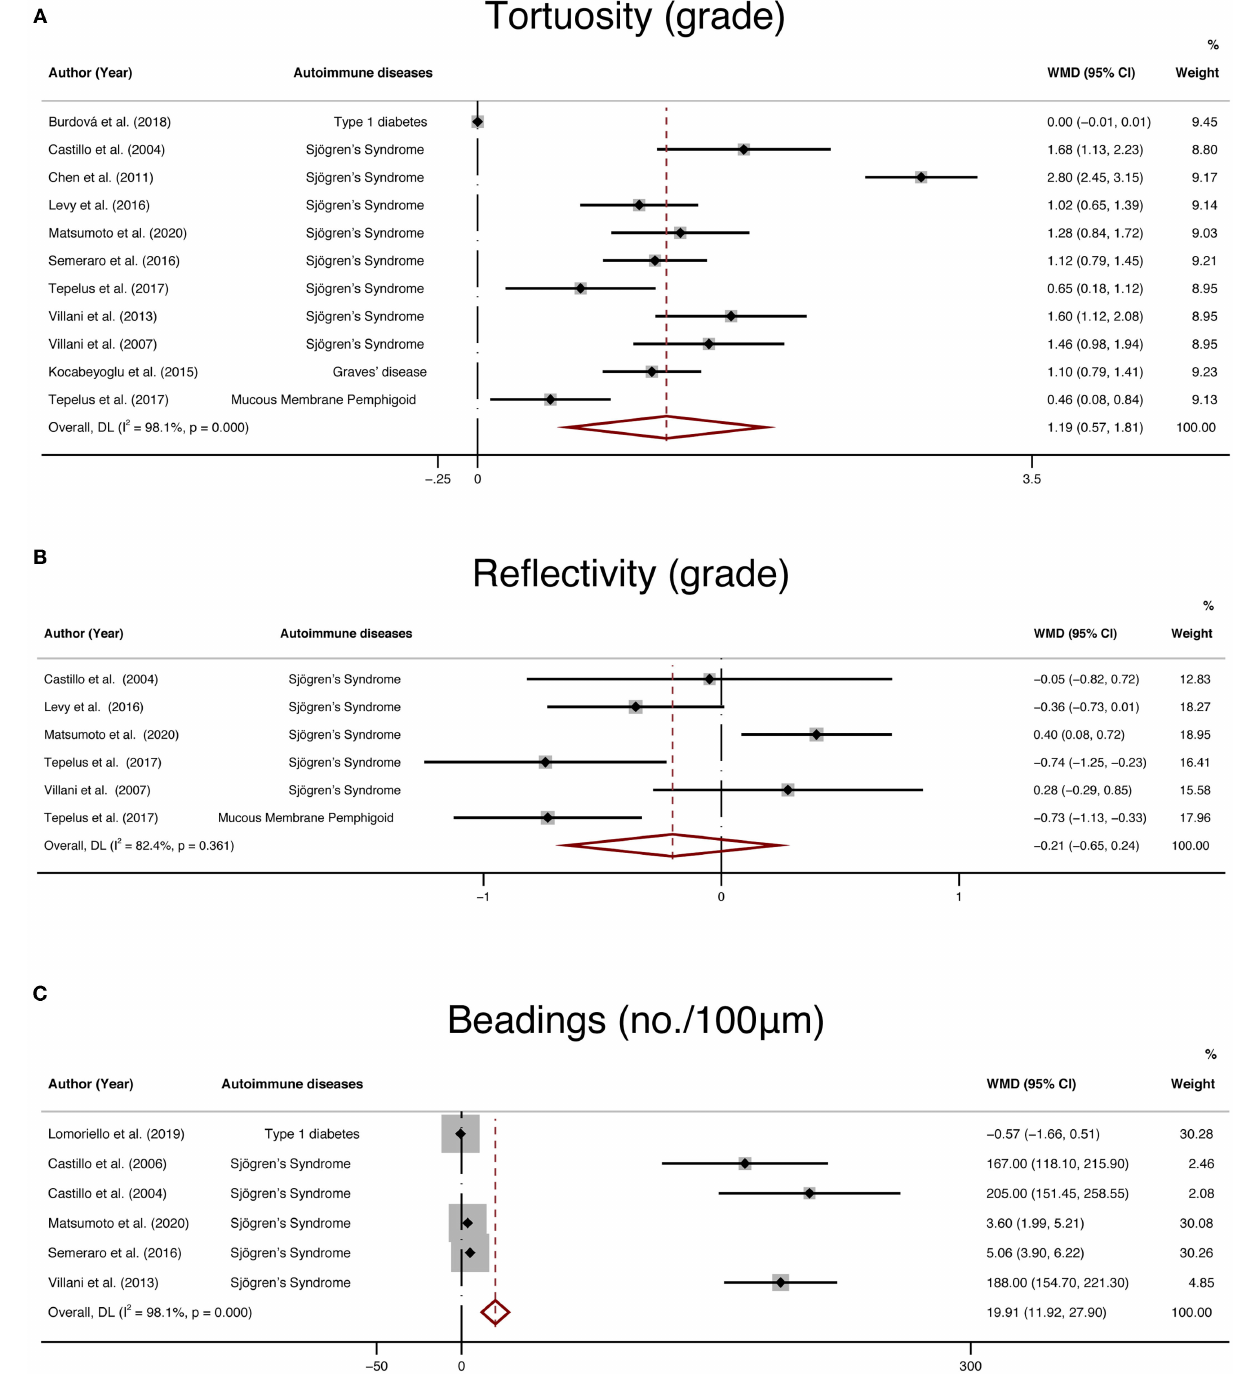
showed that tortuosity and beadings directly correlated with corneal nerve function (89). In recent years, software and methods have been developed to obtain more objective and